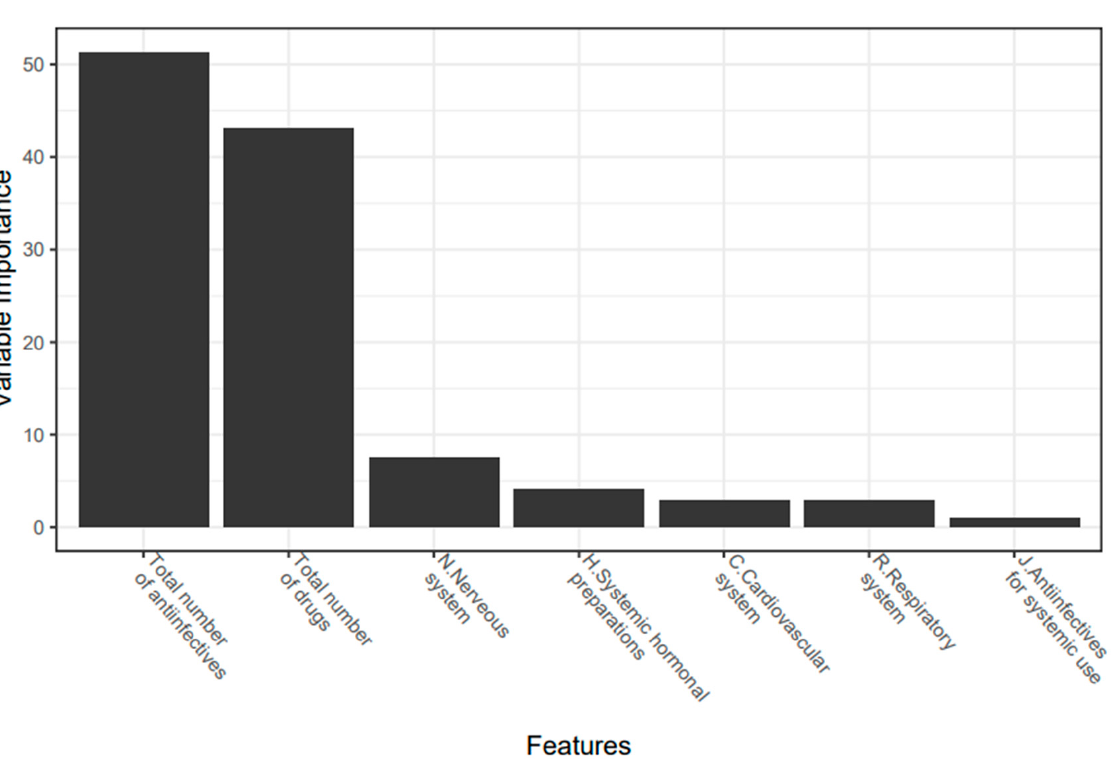
of DDI correctly classified 92.9% of the patients (Figure 3). Data were collected prospectively to examine the predictive validity of the model. In total, a sample of 51 NICU patients was reached and 15.7% (n = 8) had observed DDI. The model correctly classified 92% of them. Sensitivity and NPV were obtained as 0.75. Sensitivity and PPV were obtained as 0.92. Similar to the results of the test data set, prospective data set results had high sensitivity and